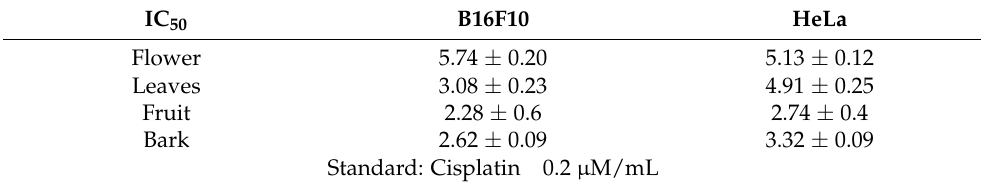
Table 10. In vitro antiproliferative activity of S. vulgaris ethanolic extracts expressed as half